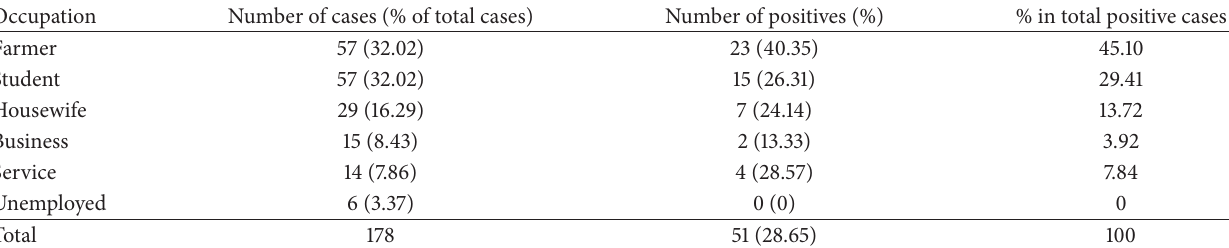
Table 4: Occupation wise distribution of